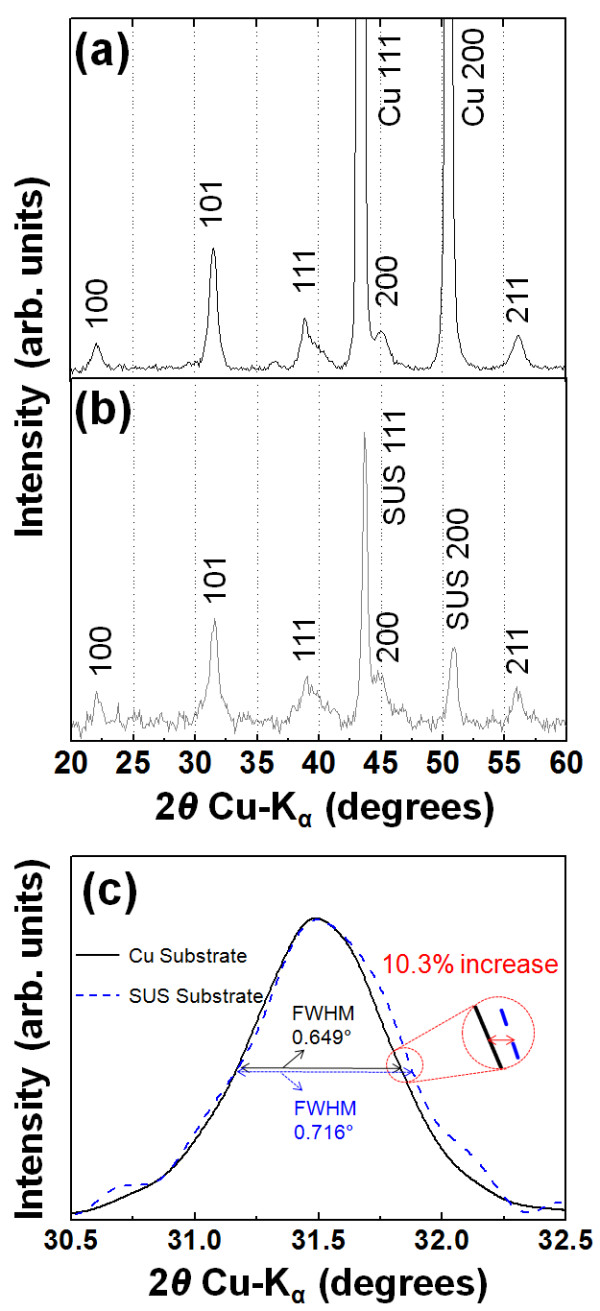
XRD patterns of the 0.2-μm-thick BaTiO3thin films on Cu and SUS substrates. (a) Cu and (b) SUS substrates. (c) Cu and SUS substrates between 30.5° and 32.5°.